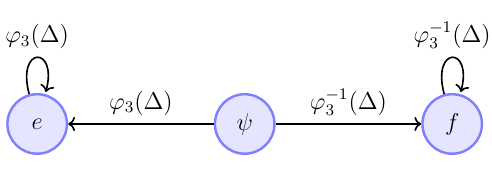
Figure 1 . The OPE relations of the a(cid:14)ne